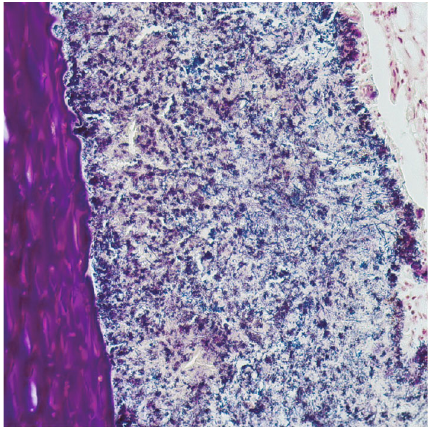
Figure 3: Brown and Brenn stain showing Actinomyces species